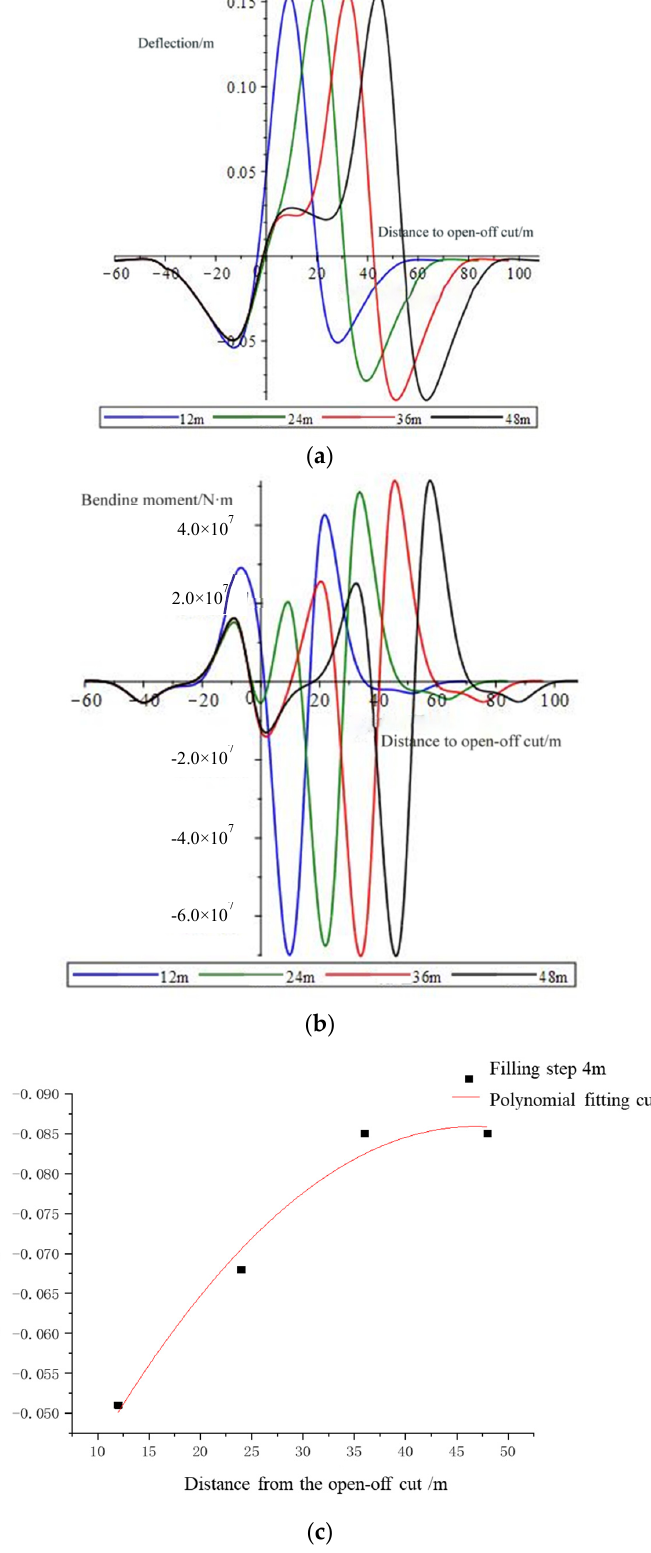
Figure 4. ( a ) Floor deflection at different advancing distances of paste-filling working face; ( b ) Bending moment of the floor under different advancing distances of paste-filling working face; ( c ) The relationship between the different advancing distances of the paste-filling working face and the maximum negative deflection of the